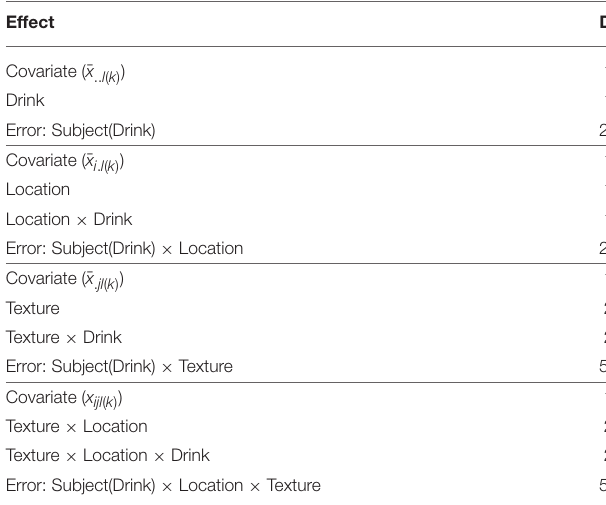
TABLE 8 | ANOVA table for the example 3-way mixed-measures model including a within-subject